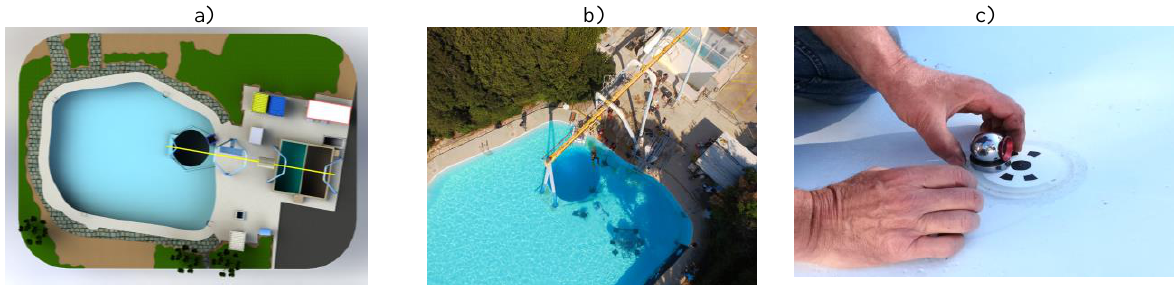
Figure 2. Underwater 3D test field set at COMEX testing pool (a,b) consisting of 200 coded targets measured with a laser tracker and spherically mounted retroreflector (c).